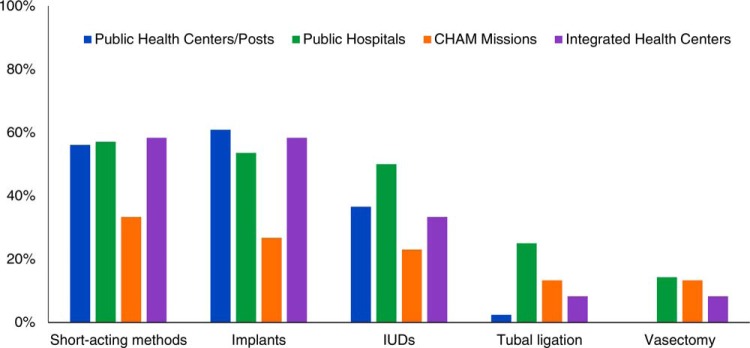
Percentage of Providers in 9 Districts in Malawi Who Reported Receiving Family Planning Training on Specific Contraceptive Methods, by Method and Facility Type, April–May 2015 (N=96)Abbreviations: CHAM, Christian Health Association of Malawi; IUD, intrauterine device.